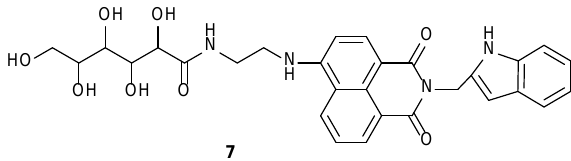
Figure 6. Sugar appended tryptamine derivative 7 .